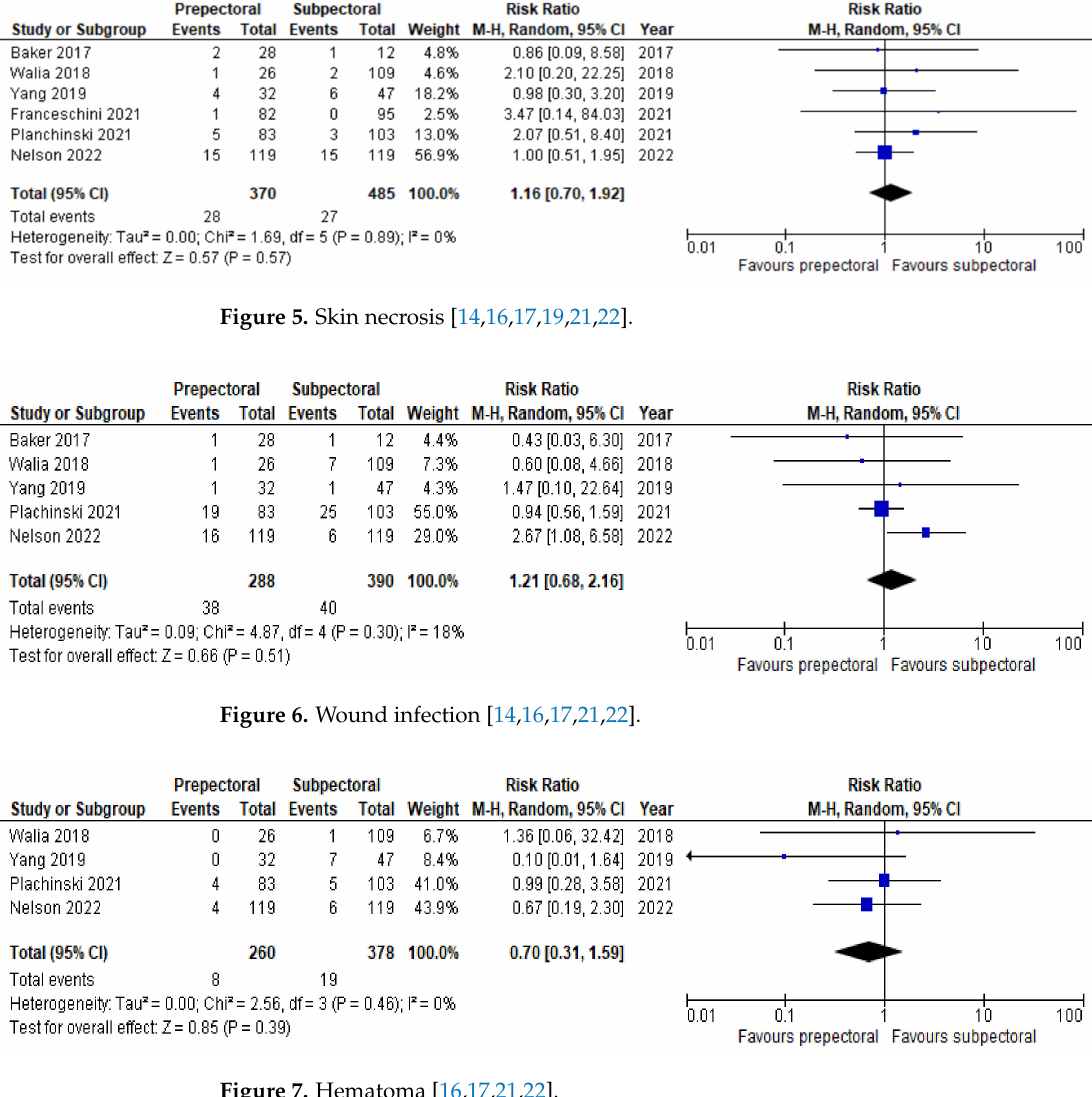
Figure 7. Hematoma